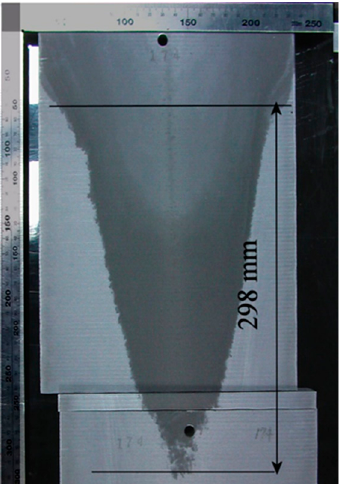
Figure 8. Profile of the sump in a billet produced by UST FRHT casting.